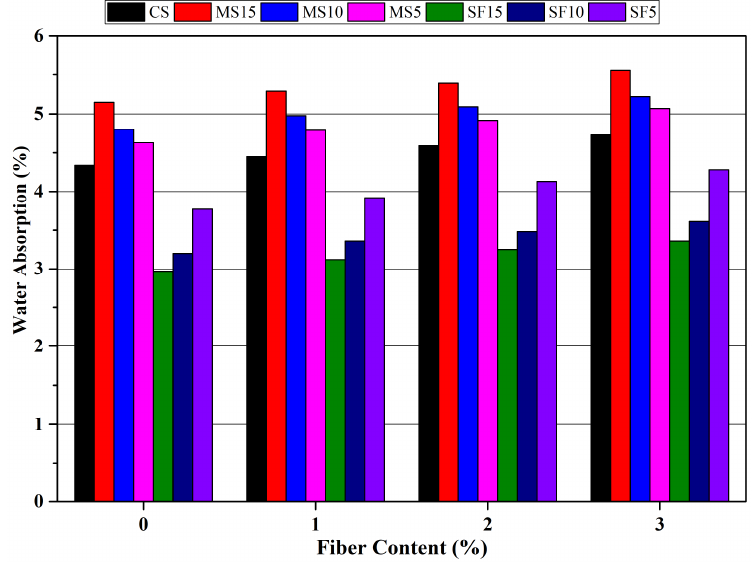
Figure 8. Water absorption values of the mortar samples .